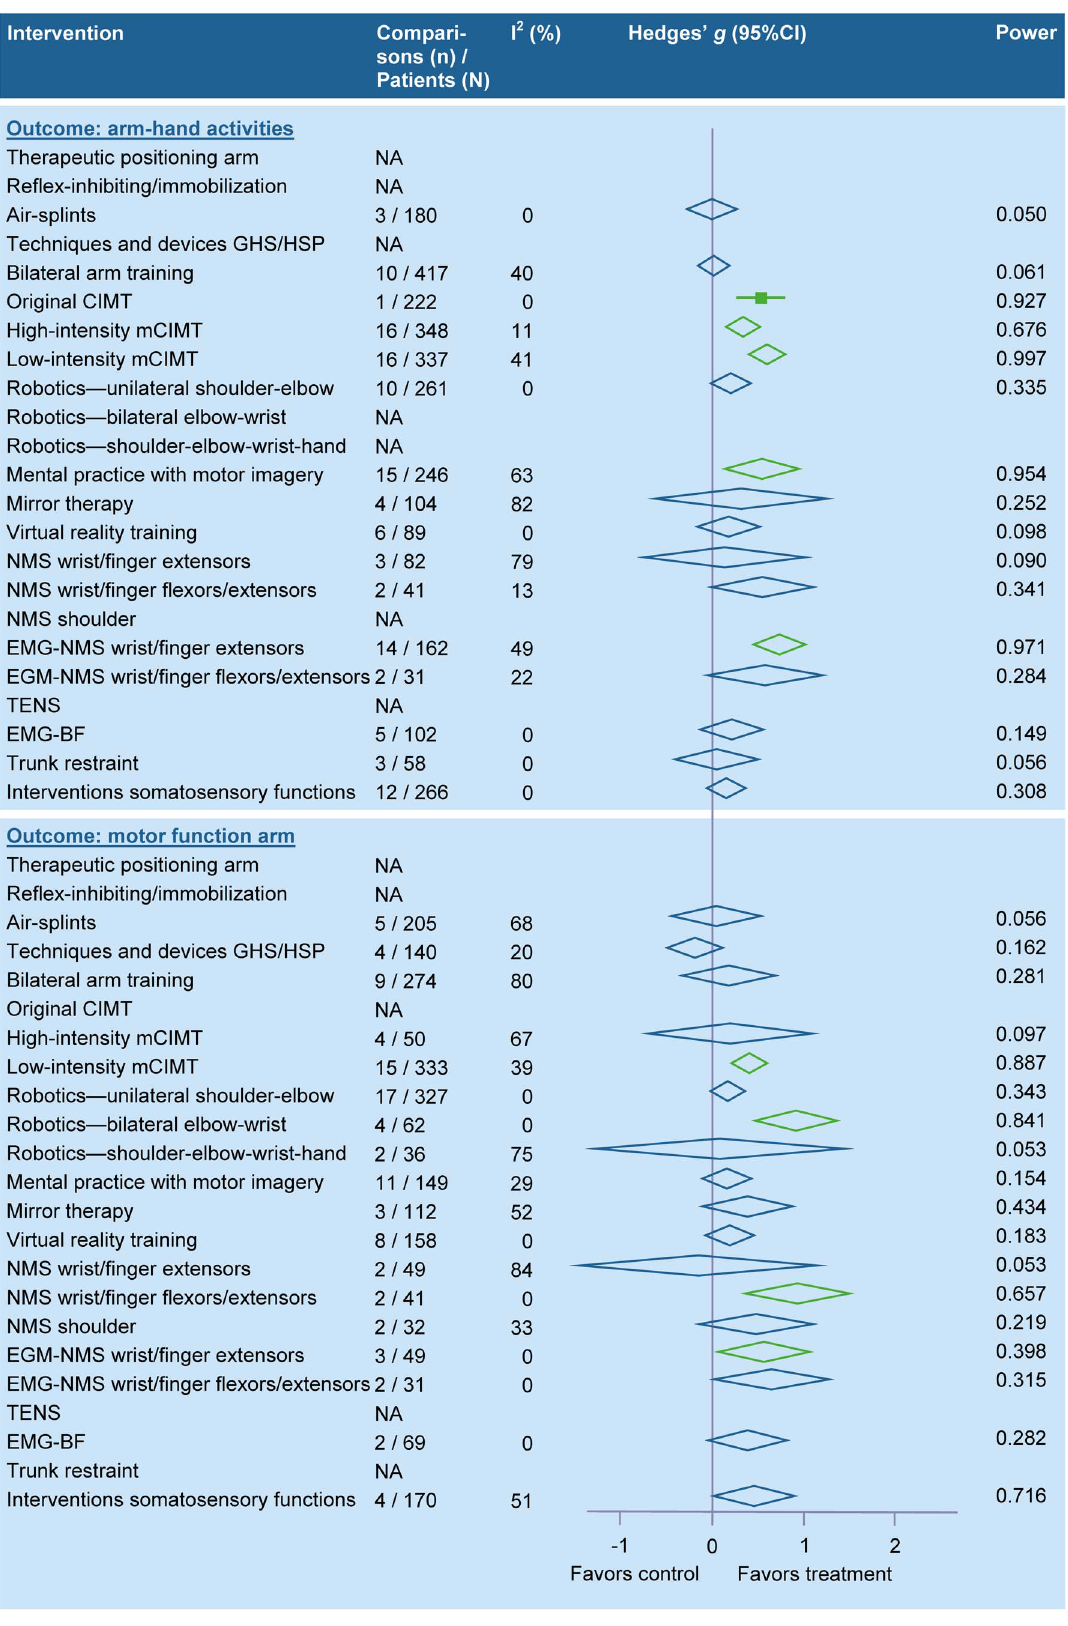
Figure 3. Summary effect sizes for physical therapy interventions – arm-hand activities. Legend: A green colored diamond indicates that the summary effect size is significant, while a blue colored diamond indicates that the summary effect size is nonsignificant; CI, Confidence Interval;